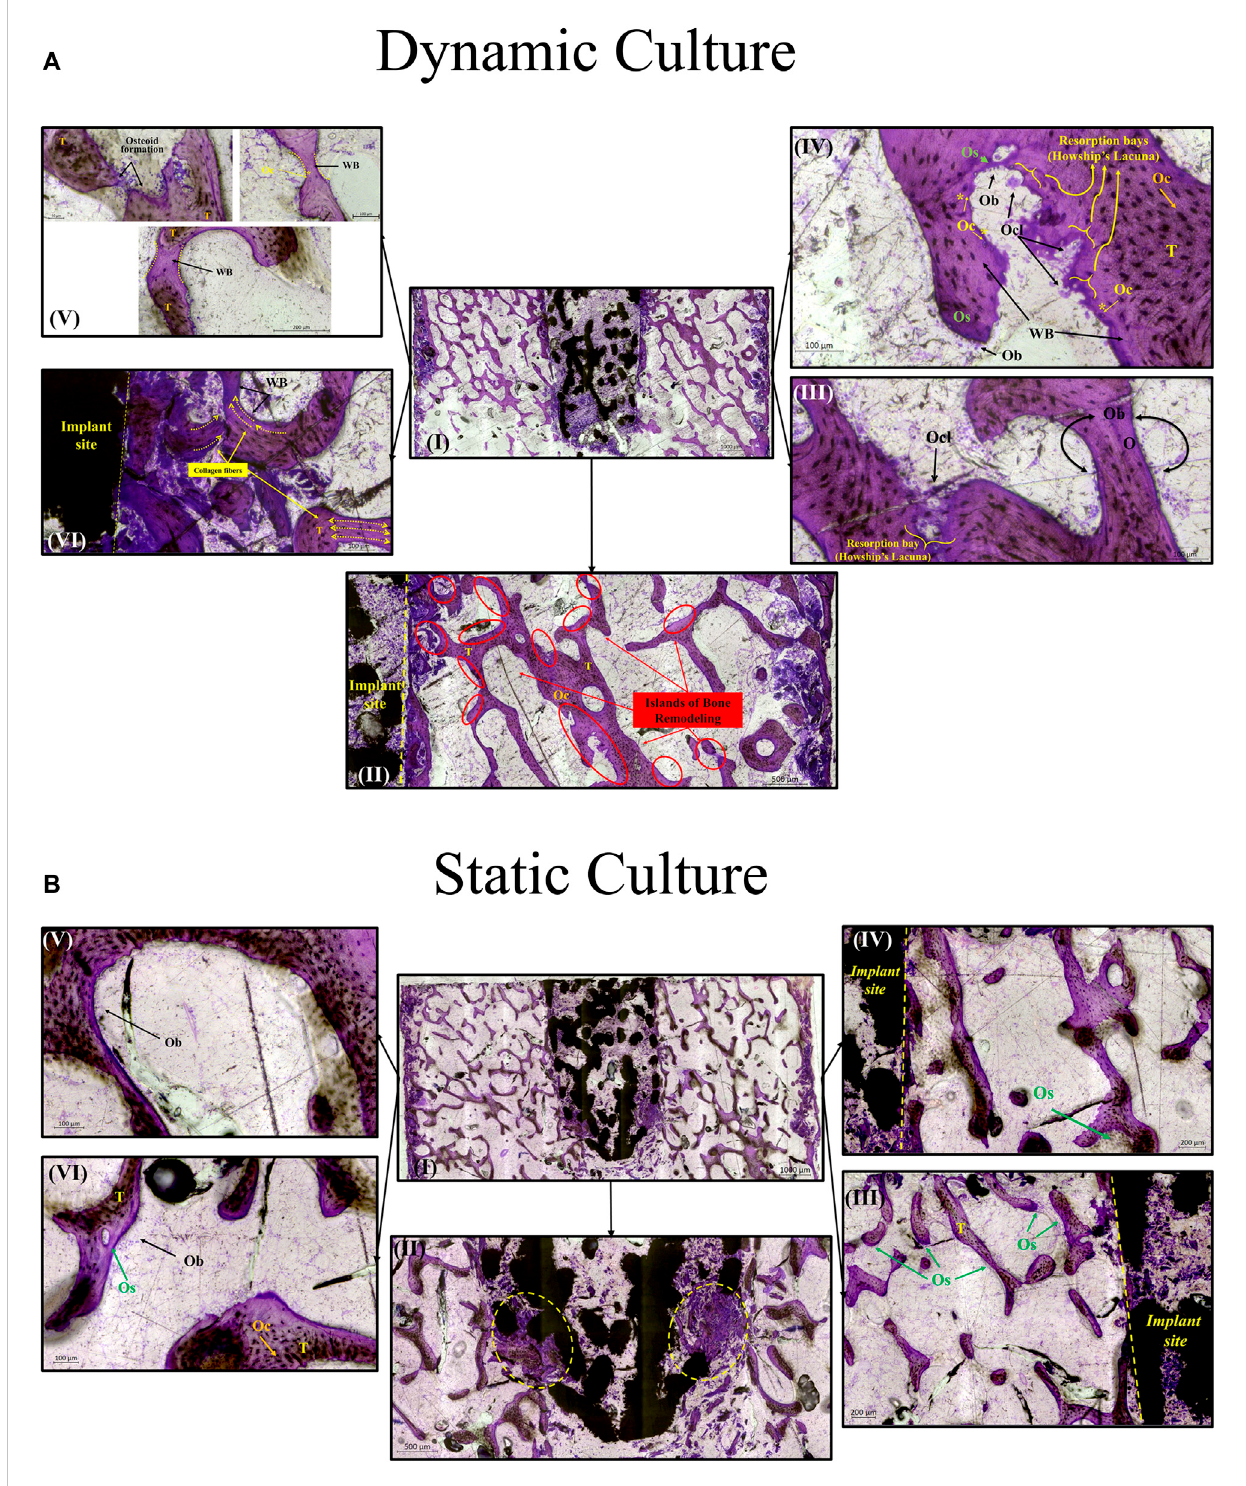
FIGURE 7 Transversetissue sections stained withParagon — Toluidine blue (A) Ex-vivo cancellousbone cultured for 21 Dayswithin bioreactor (I) Crosssection of the bone cylinder, (II) representative areas next to the implant fi xation showing the newly formed bone tissue islands (red circles) on the existing trabeculae struts (T), (III) bone remodelling produced from osteoblasts (Ob) lining on both sides of the trabeculae, and bone resorption by osteoclasts (Ocl) occupying small depressions on the bone surface (Howship ’ s lacunae), (IV) areas of new osteoid formation (Os), woven bone (WB), bone resorption activity (Howship ’ s lacunae) and some newly formed Osteocytes (Oc*) together with mature osteocytes (Oc), (V) existing trabeculae struts with formation of newosteoid(Os) and woven bone formation bridging trabeculae struts with newly formedOsteocytes (Oc*) trapped inside,(VI) woven bone formation near the implant site with collagen fi bers situated parallel in sheets and oriented opposite to the mechanical force acting on the sample. (B) Staticculturefor21 Days(I)Crosssectionofthebonecylinders,(II)conicaledgeofthepegwithcircleshighlightingmixedbonetissue(oldmineralized boneandnew connective tissuereformation),(III)leftsideand(IV)rightsideofbone nexttotheimplant showingminor islands ofosteoid(Os)formation, (V) and (VI) areas away from the implant with osteoblasts (Ob) forming new osteoid (Os). Scalebars are shown within the